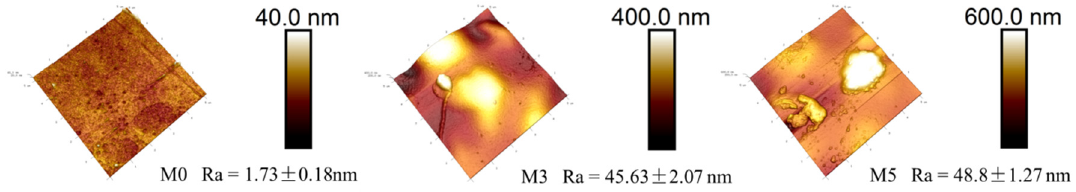
Figure 7. Atomic force microscope (AFM) images of the M0, M3, and M5 membranes.